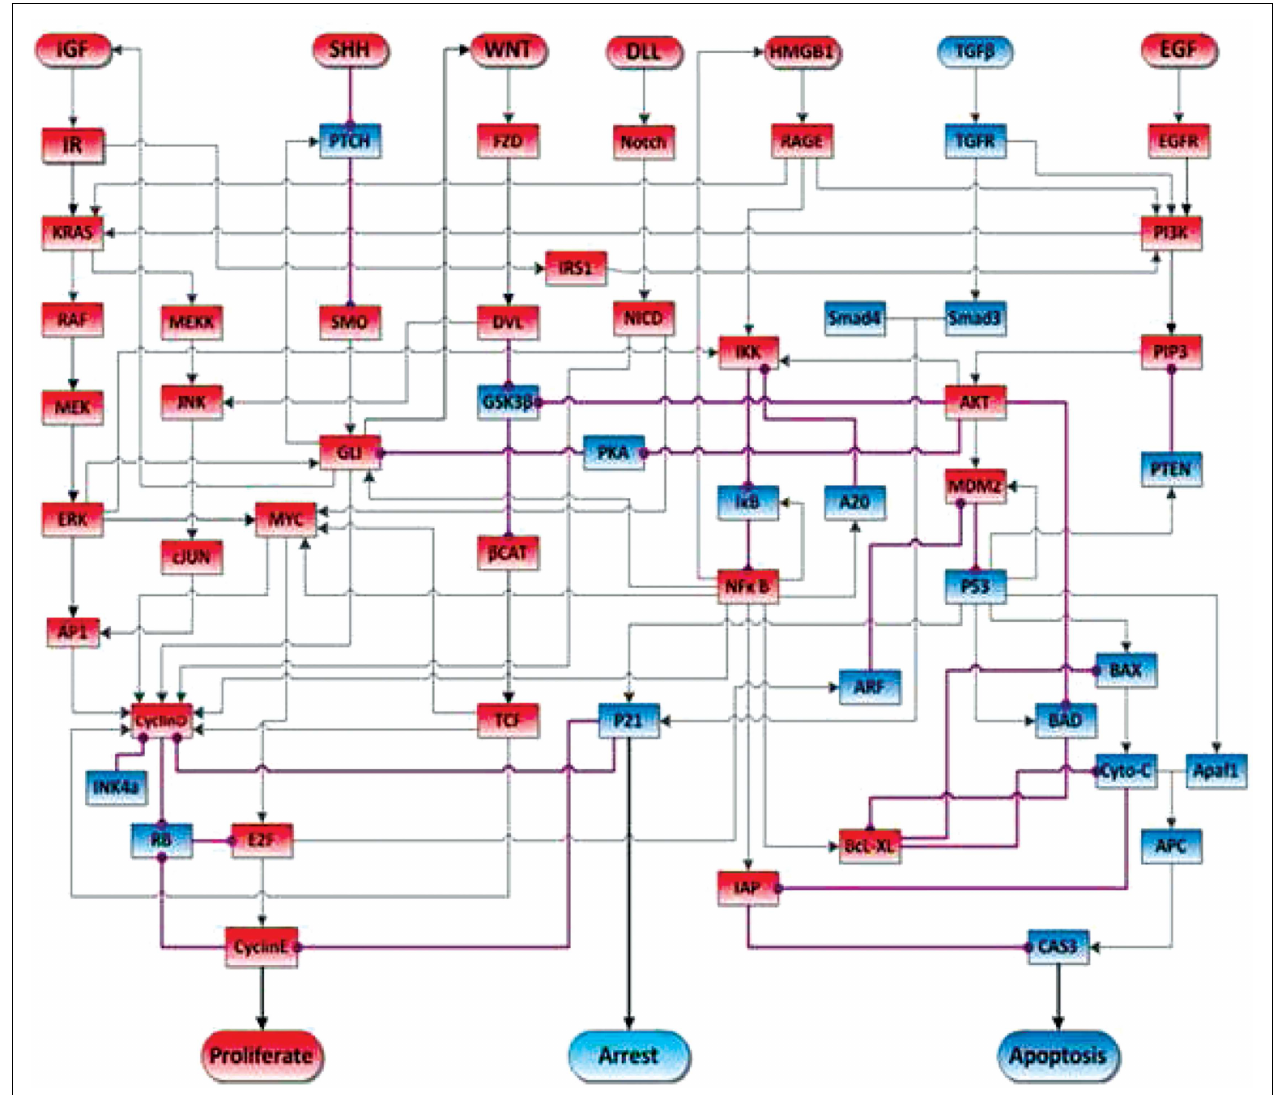
node stand for signal transduction proteins.The rounded rectangular nodes on the top of the figure stand for ligands that activate the pathways. Finally, the rounded nodes at the bottom stand for a cell behavior activated by the connected effector proteins. Figure adapted from Gong et al.